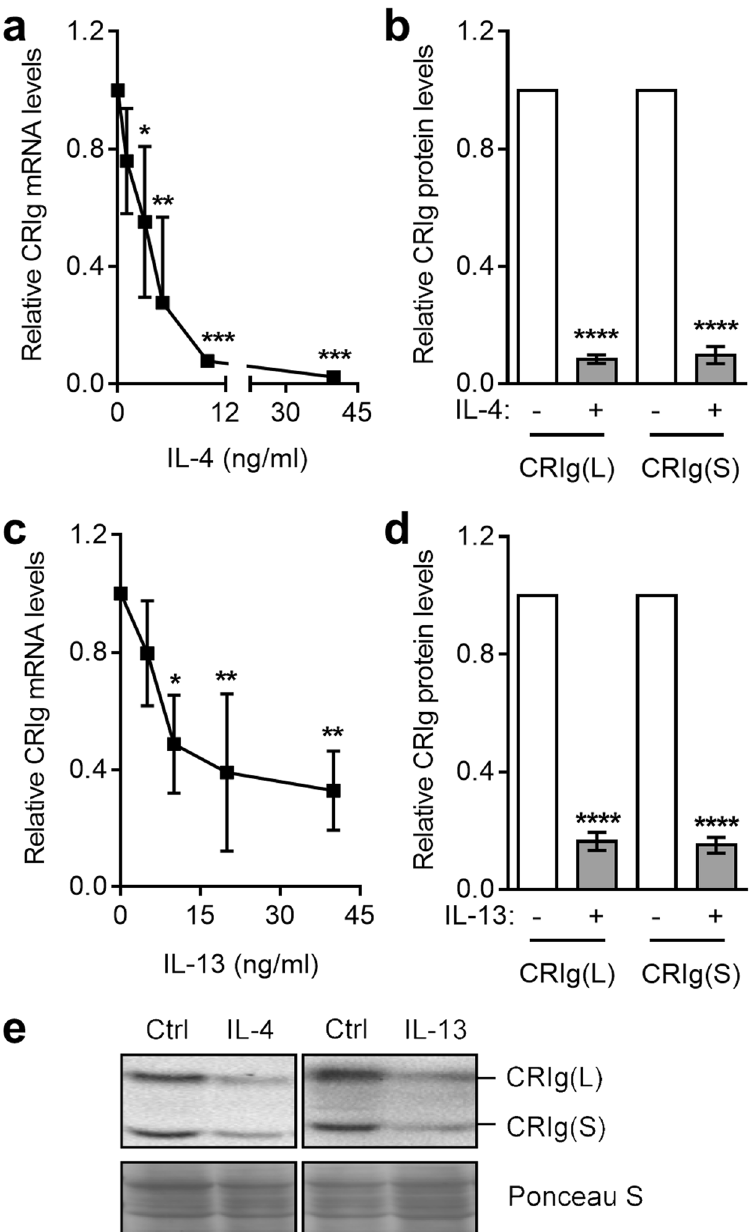
Figure 2. IL-4 and IL-13 down-regulate the development of CRIg + . Monocytes were cultured in the presence of 0, 1, 3, 5, 10, and 40 ng/ml IL-4 ( a ) or 0, 5, 10, 20, and 40 ng/ml IL-13 ( c ) and CRIg mRNA expression was measured by qPCR. For CRIg protein expression the monocytes were treated with 40 ng/ml ( b ) IL-4 or IL-13 ( d ). ( e ) Representative Western blots of CRIg levels (IL-4 and IL-13 treatments were analysed on separate blots). Data are presented as means ± SD of three experiments, each conducted with cells from different individuals. * p < 0.05, ** p < 0.01, *** p < 0.001, **** p <